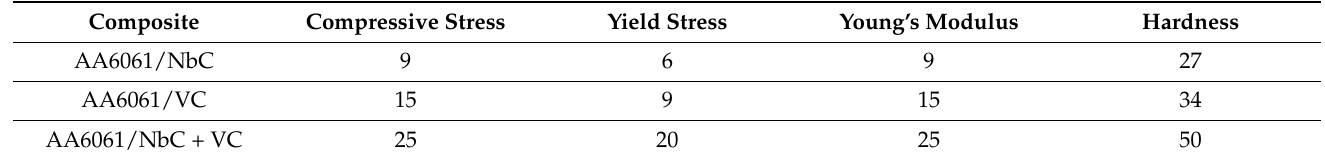
Table 4. The improvement of the mechanical properties with respect to the base metal